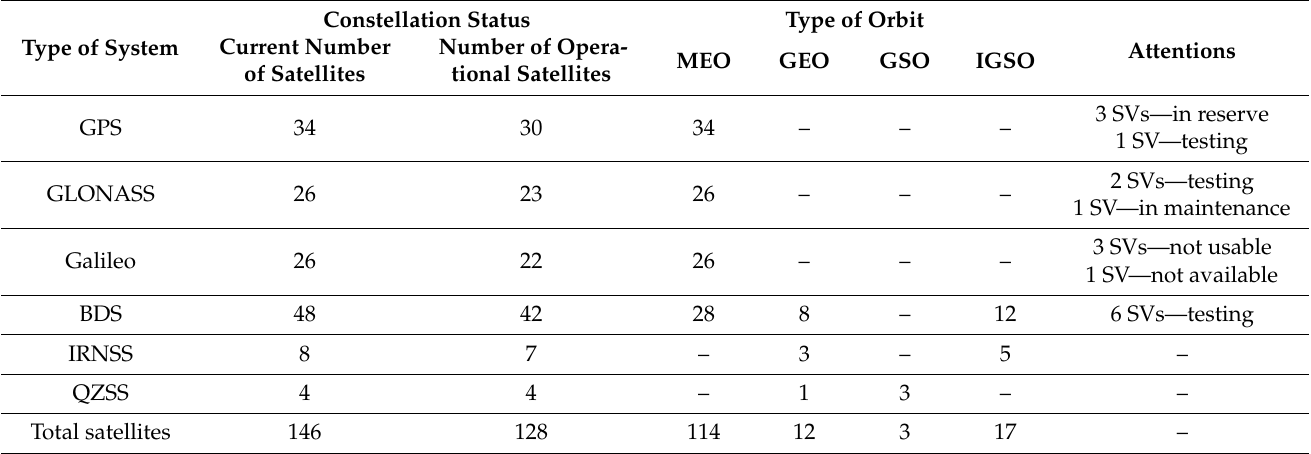
Table 1. The current status of the autonomous navigation system constellations (as of 26 August 2021). Constellation Status Type of Orbit AttentionsCurrent Number Type of System of